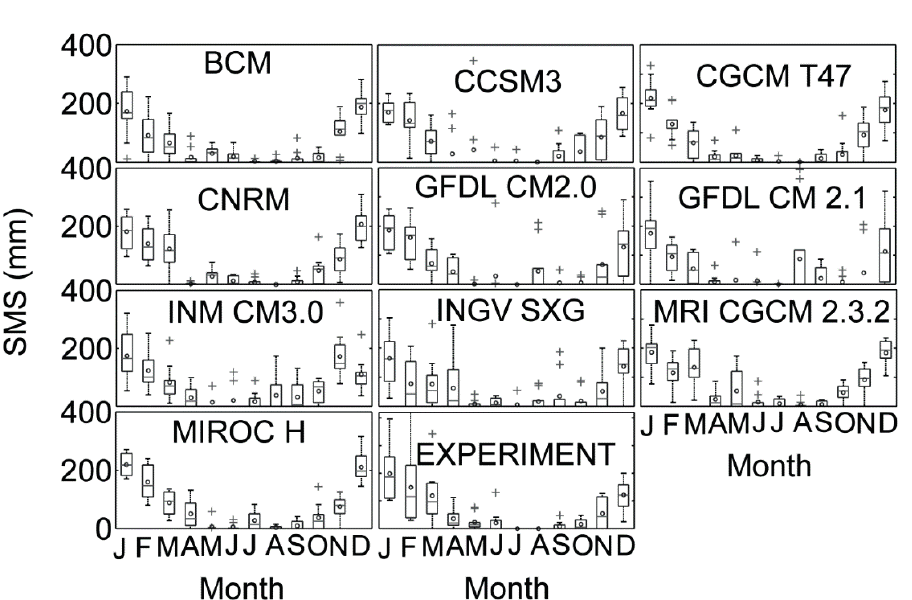
Fig. 4 Experimental and GCMs’ monthly SMS for